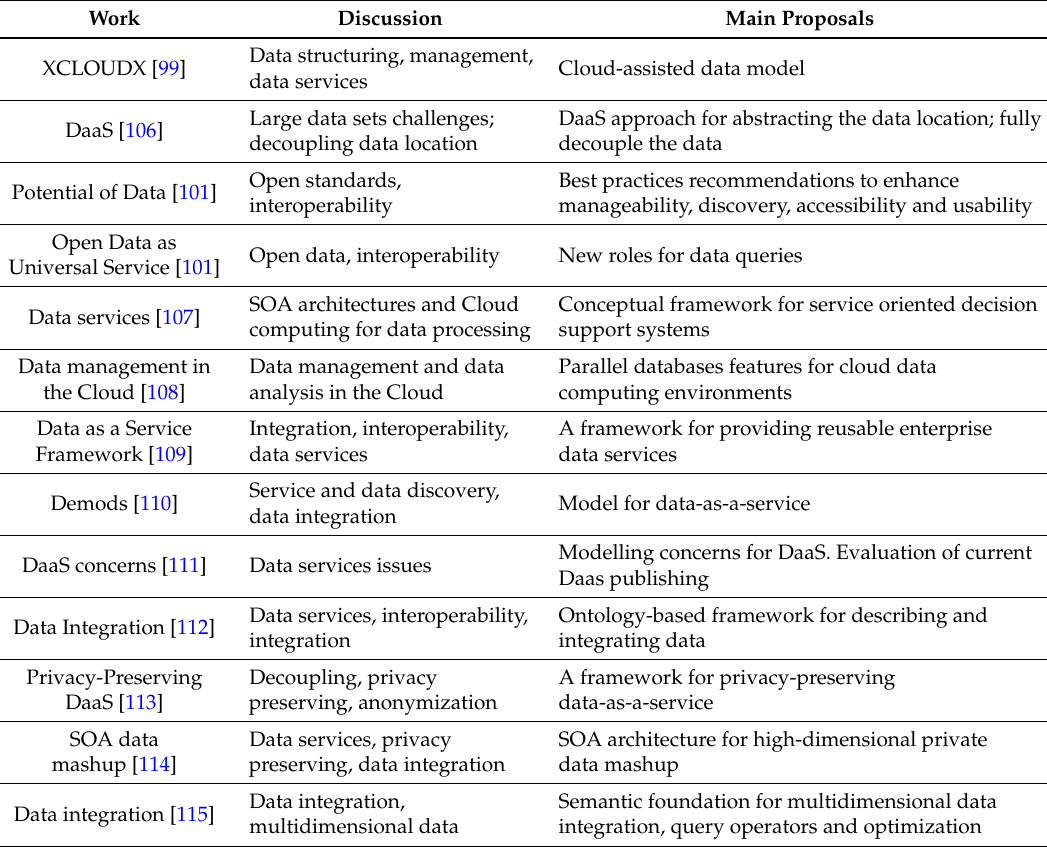
Table 4. Recent work on issues for offering quality DaaS.